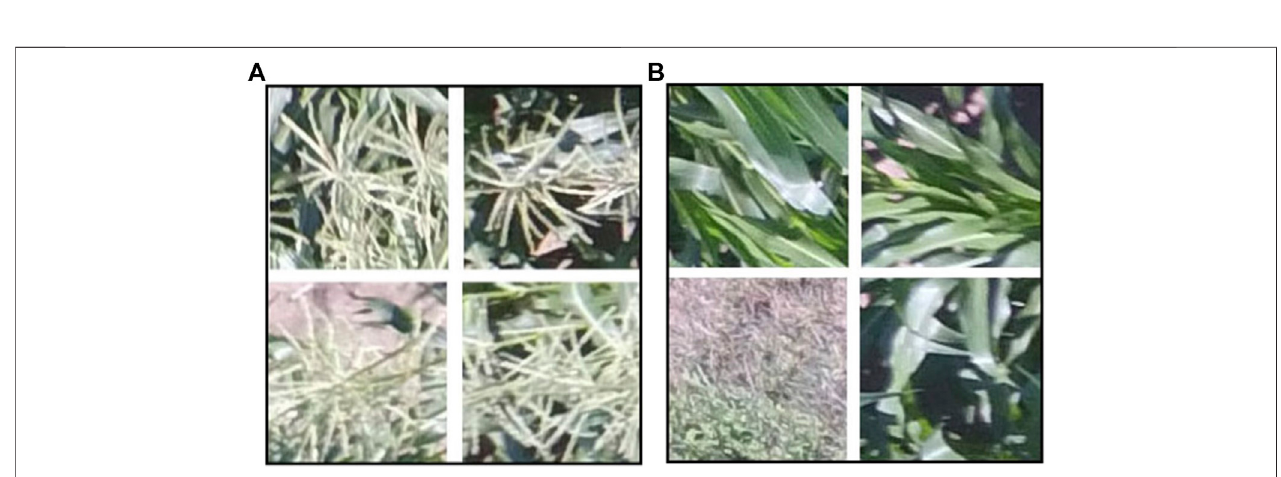
FIGURE 2 | [Best viewed in color] Examples of the dataset used for the TD-CNN model: (a) “ tassel ” class images (b) “ no_tassel ” class images.